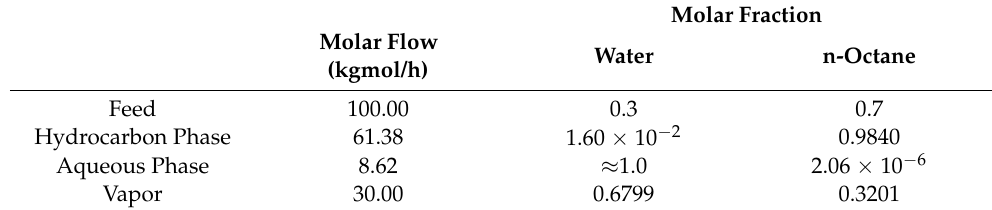
Table 5. HYSYS V9 results for three-phase flash calculations at T = 100 ◦ C using SRKKD.